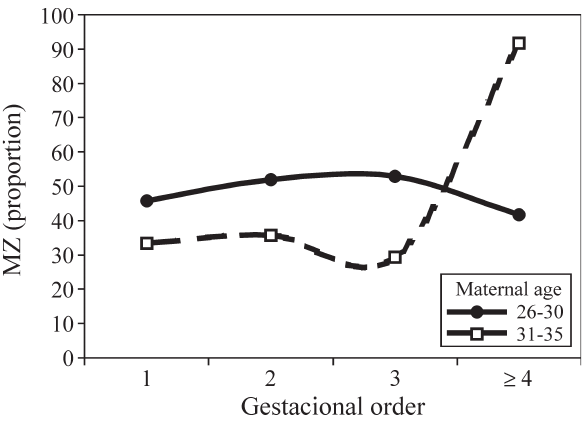
Figure 2 - Monozygotic twin proportions in two maternal age groups (26-30 and 31-35 years) according to gestational